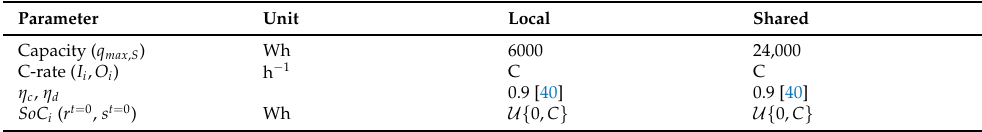
Table 5. BESSs parameters. Parameters in Table 3 corresponding to the entries of this table have been placed in brackets. The subscript S in q max , S stands for “Storage”; this term does not have